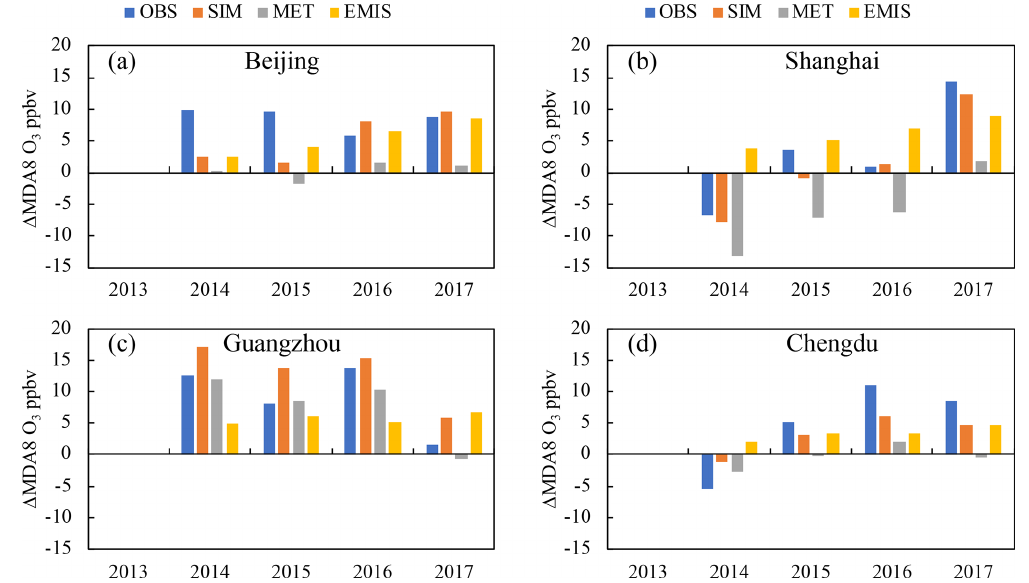
Figure 4. Interannual changes in the simulated (SIM) and observed (OBS) summer surface MDA8 O 3 mixing ratios and those due to variations in meteorological conditions (MET) and anthropogenic emissions (EMIS) in (a) Beijing, (b) Shanghai, (c) Guangzhou, and (d) Chengdu in 2013–2017 relative to 2013.